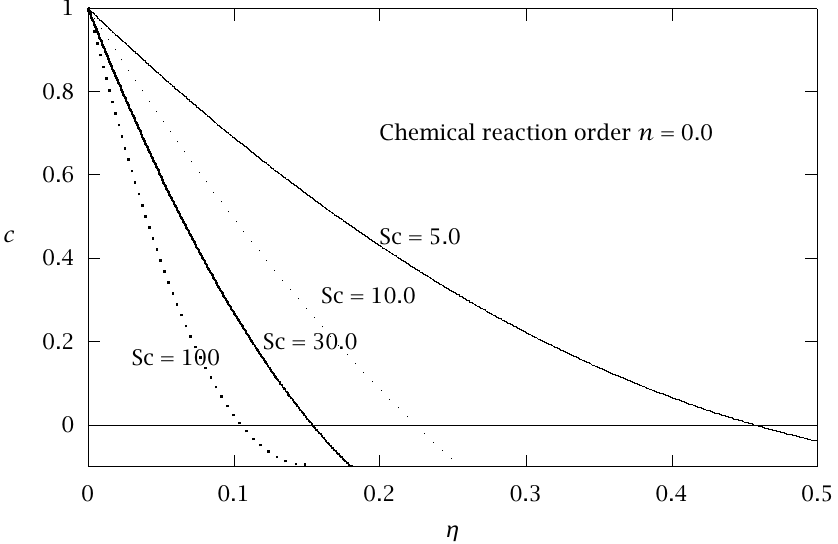
Figure 5.4 . Zeroth order concentration profiles.